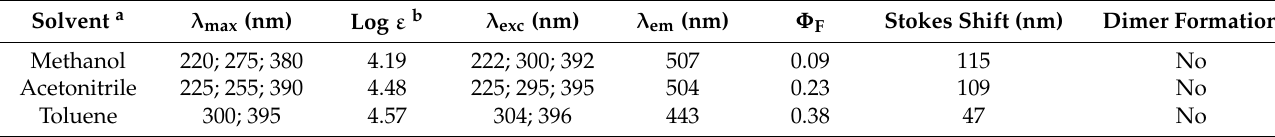
Table 1. Photophysical results for the compound 7 in three different solvent